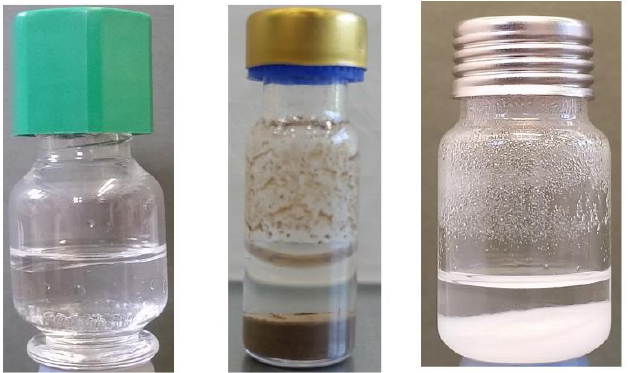
Figure 4. Autosampler vials after (i) extraction ( left , billimex ® ), (ii) centrifugation ( middle ) and (iii) drying (vortexed) with Na2SO4 ( right ).